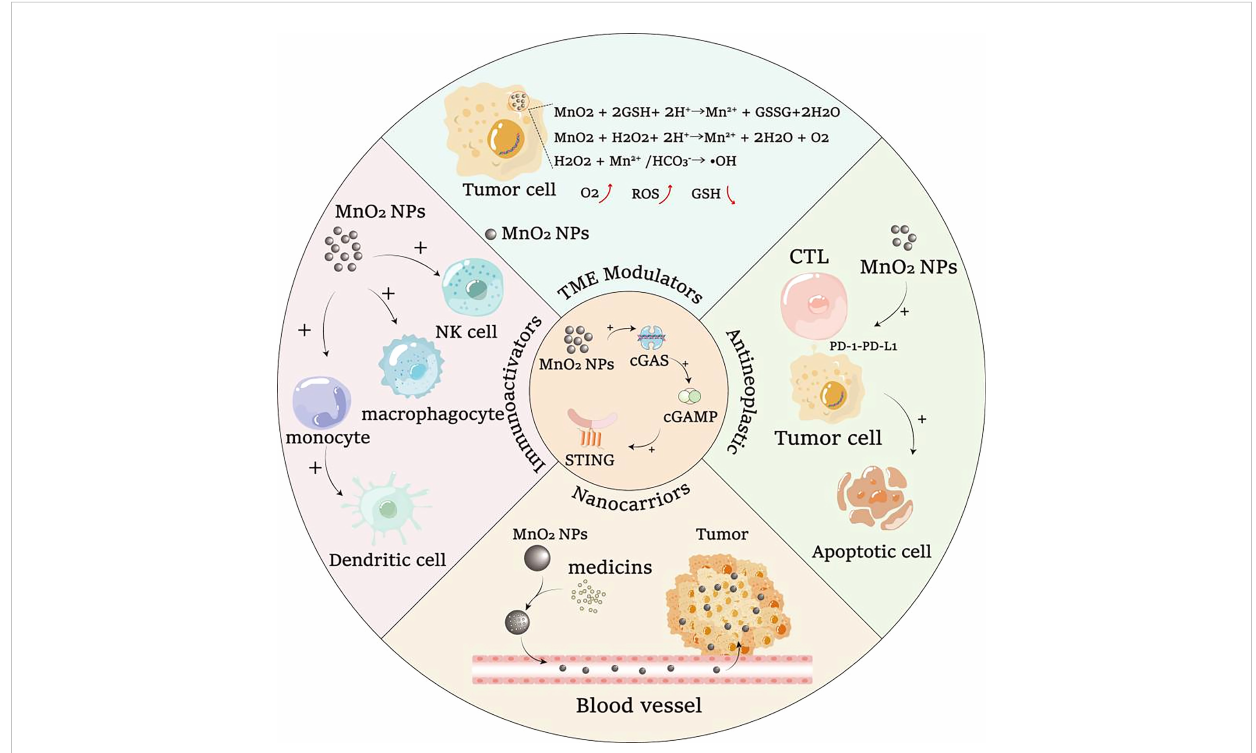
FIGURE 3 The ability of MnO 2 nanomaterials to activate cGAS-STING signaling pathway can cooperate with other biological functions of MnO 2 nanomaterials for potential synergistic treatment of